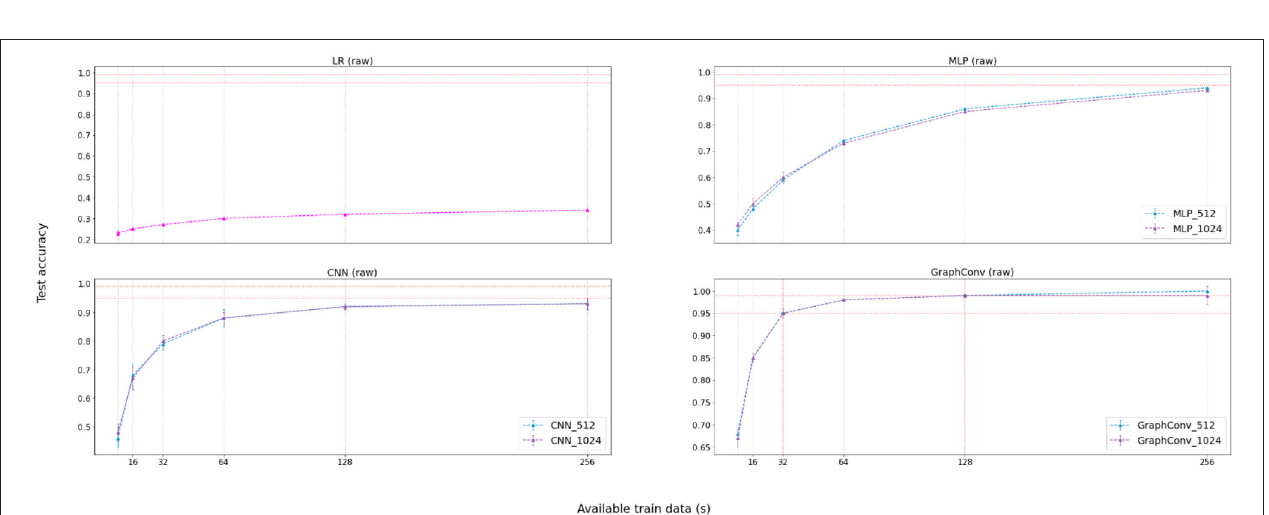
results demonstrate that features learned by the CNN contain less expressive information than the GraphConv , at least when constraining the training dataset size. Results also imply that the automatic feature extraction method is better than feeding the raw data into a classifier directly, given that both LR and MLP performed poorly when the data was not